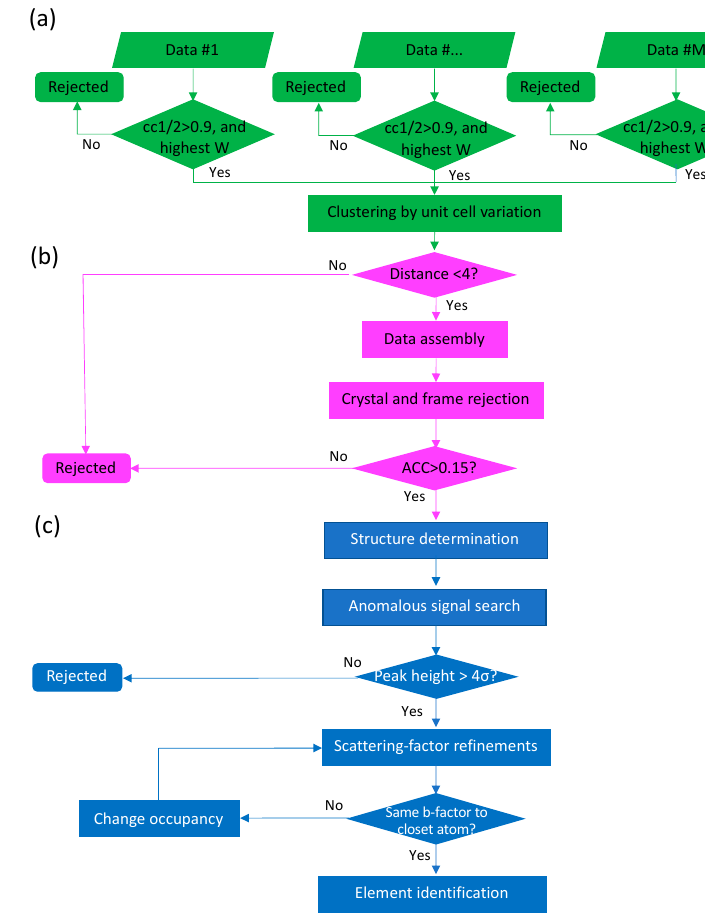
Figure 1. Schematic workflow for Na + identification. ( a ) Single-crystal data set processing. Single- crystal data sets were independently indexed, integrated, and scaled using PyMDA as 10 progres- sively accumulated wedges (W) (W1, 1–60; W2, 1–120; . . . , W10, 1–600 frames). The largest wedges which have CC1/2 > 0.9 were selected for further data analysis. ( b ) Data assembly and rejection. Data sets classified with a unit-cell variation of less than 4 were combined. Unit-cell variation is defined as Euclidean distances normalized by population variances as reported previously [28]. Assembled data sets were subjected to crystal rejection followed by frame rejection by PyMDA. Only data sets that showed significant anomalous signals (ACC > 0.15) were advanced to the next step. ( c ) LeuT structure was determinized by molecular replacement using PDB code 3GJD as a search model. Anomalous signals were searched by ANODE. Significant anomalous signals (>4 σ ) at the Na + binding site were subjected to f” refinement by PHENIX.REFINE. The occupancy of anomalous scatterers was changed from 1.0 to 0.1 in 0.1 intervals to get refined individual B-factor and f” values. The refined f” value of an anomalous scatterer that has a B-factor value closest to its neighboring atom(s) was selected. The element was assigned by comparing the refined f” value with its theoretical value at 5